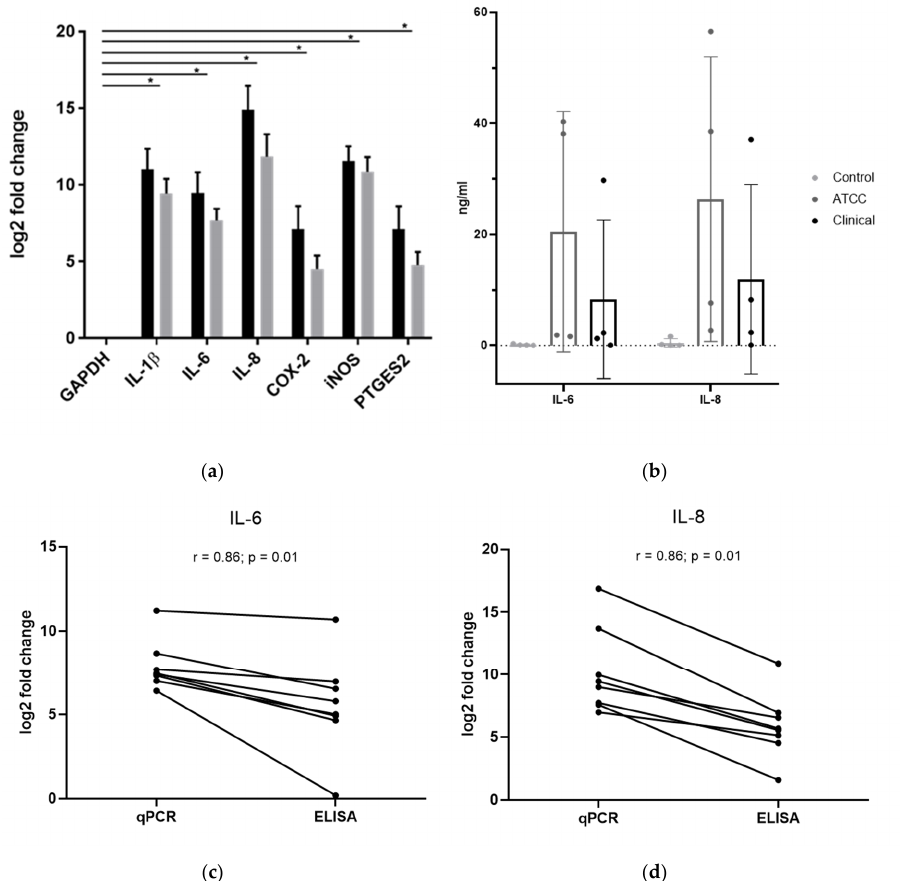
Figure 1. C. acnes -induced changes of pro-inflammatory markers in intervertebral disc (IVD) cells. The black bars display results obtained with the ATCC C. acnes strain, whereas light grey shows